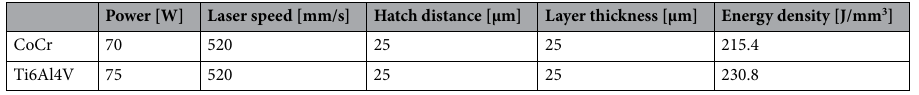
Table 2. Laser parameters for the CoCr and Ti6Al4V 3D printed alloys, using both virgin and reused